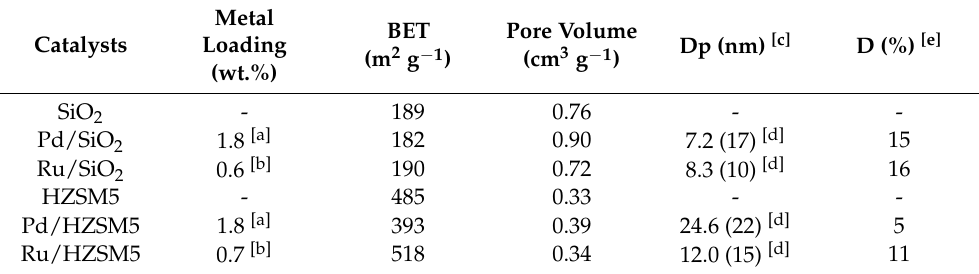
Table 1. Pd and Ru content, specific surface area, pore volume, particle size and dispersion of palladium and ruthenium-supported catalysts.